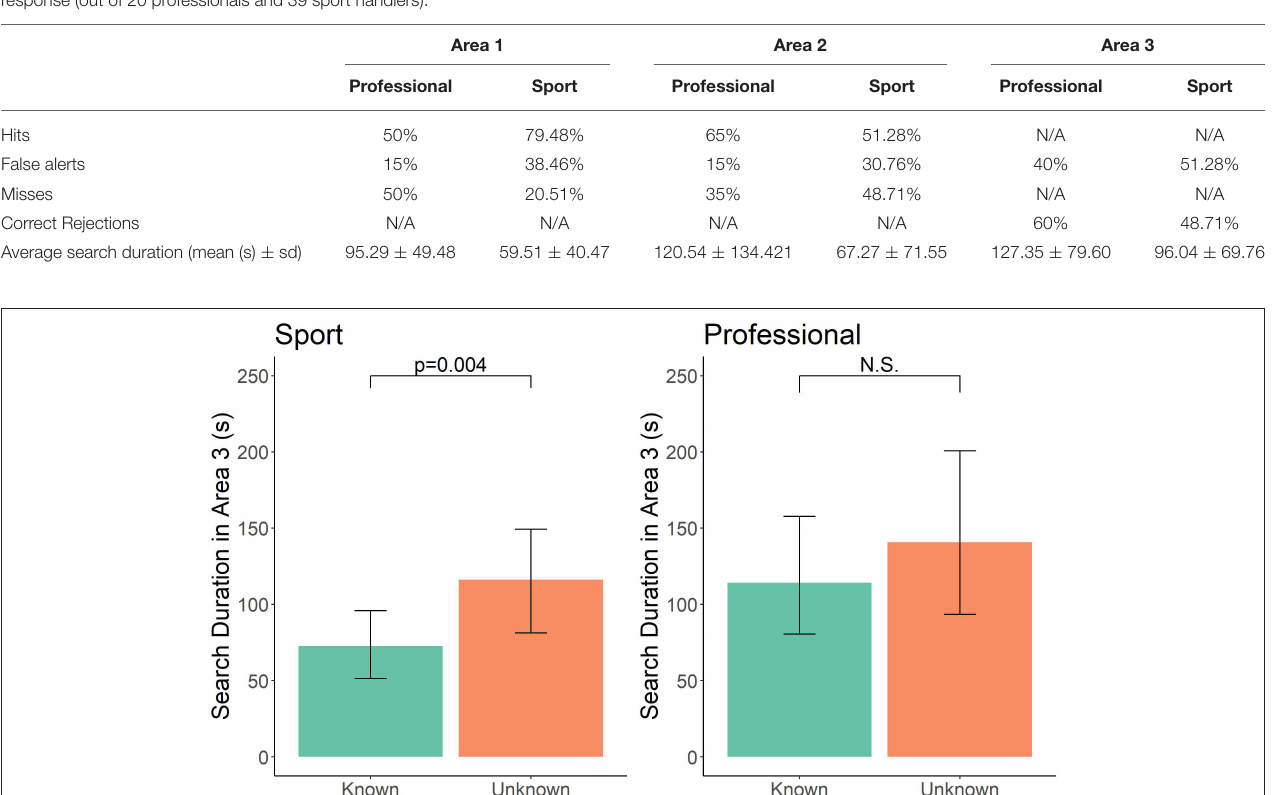
FIGURE 1 | Known vs. Unknown group in sport and professional handler dog teams for total search duration in area 3. Error bars represent 95% confidence intervals.